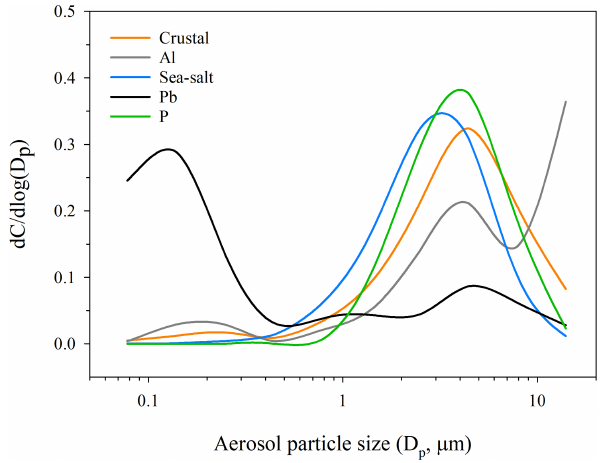
Figure 6. The results of k -means clustering on the normalized mean aerosol particle-size distributions. The crustal cluster includes Ti, V, Mn, and Ce; the sea-salt cluster includes Na + , K + , and